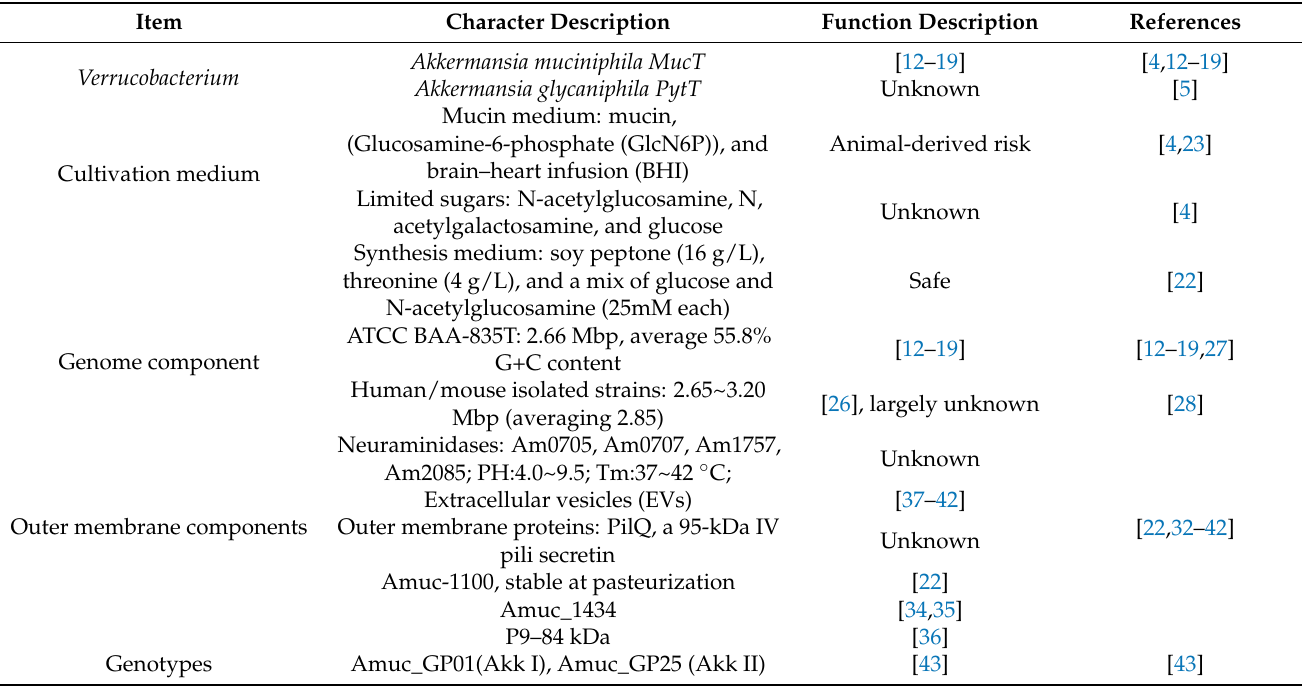
Table 1. Physiological character and components of Akkermansia muciniphila